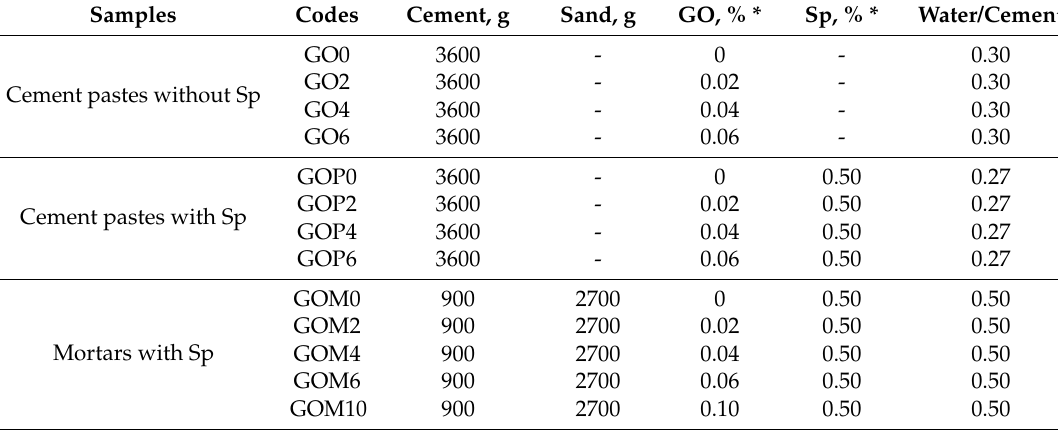
Table 5. Codes of cement paste and mortar